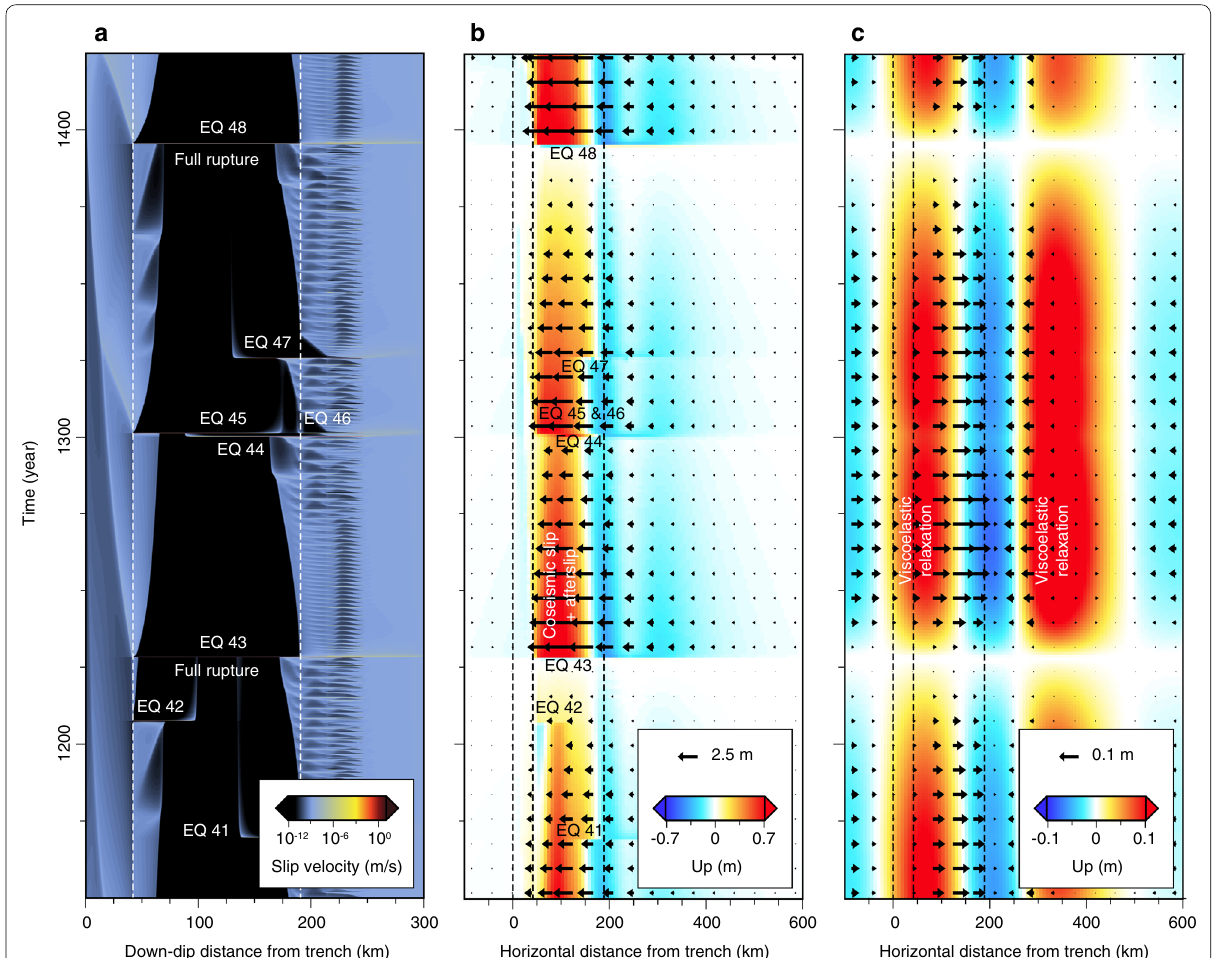
Fig. 8 Contribution of fault slip and upper-mantle flow to vertical and trench-perpendicular surface displacements throughout the seismic cycle. a Megathrust slip instabilities and locking are distributed in space and time. b Fault slip produces seaward displacement above the megathrust and small landward displacement in the outer rise (denoted by arrows). Fault slip also produces significant uplift in the forearc region above the major rupture area and subsidence outside this region. Small coseismic subsidence close to the landward side the trench is caused by the locking in the shallowest portion of the megathrust (background color). c Postseismic viscoelastic flow in the asthenosphere following full ruptures produces landward displacement (white arrows) on the seaside of the mantle wedge corner and seaward displacement on the other side. Uplift is found above the rupture area and most of the mantle wedge. Viscoelastic subsidence is found mostly above the metamorphic belt and in the outer